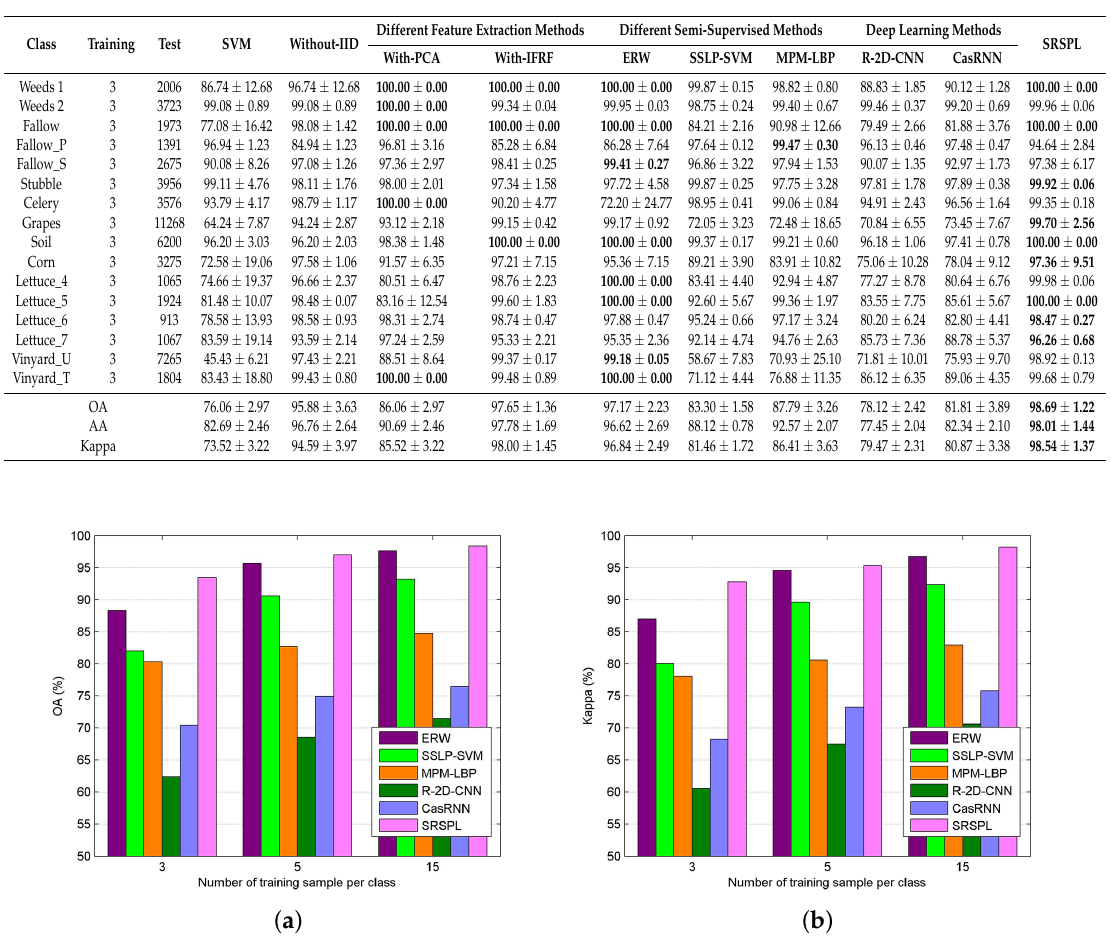
Figure 13. The classifications of different methods for the Kennedy Space Center image when the number of training samples increases from three per class to 15 per class. ( a ) OA; ( b ) Kappa coefficient.